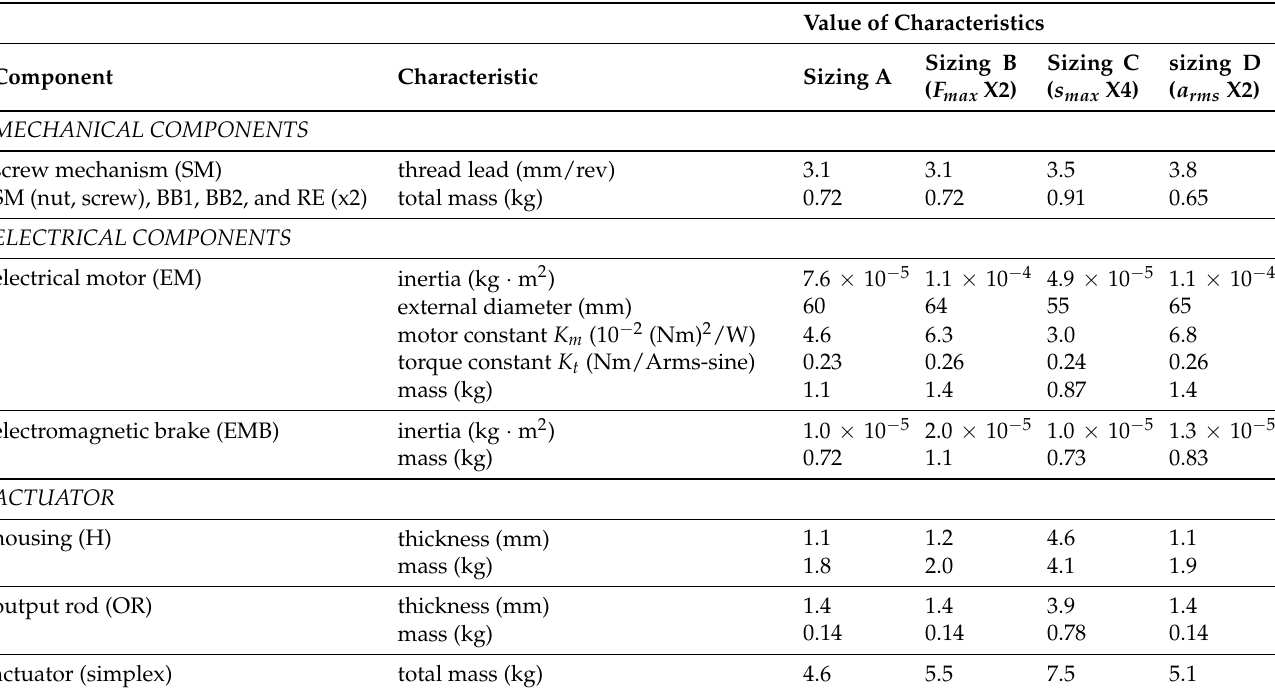
Table 6. Sizing results from the arbitrary